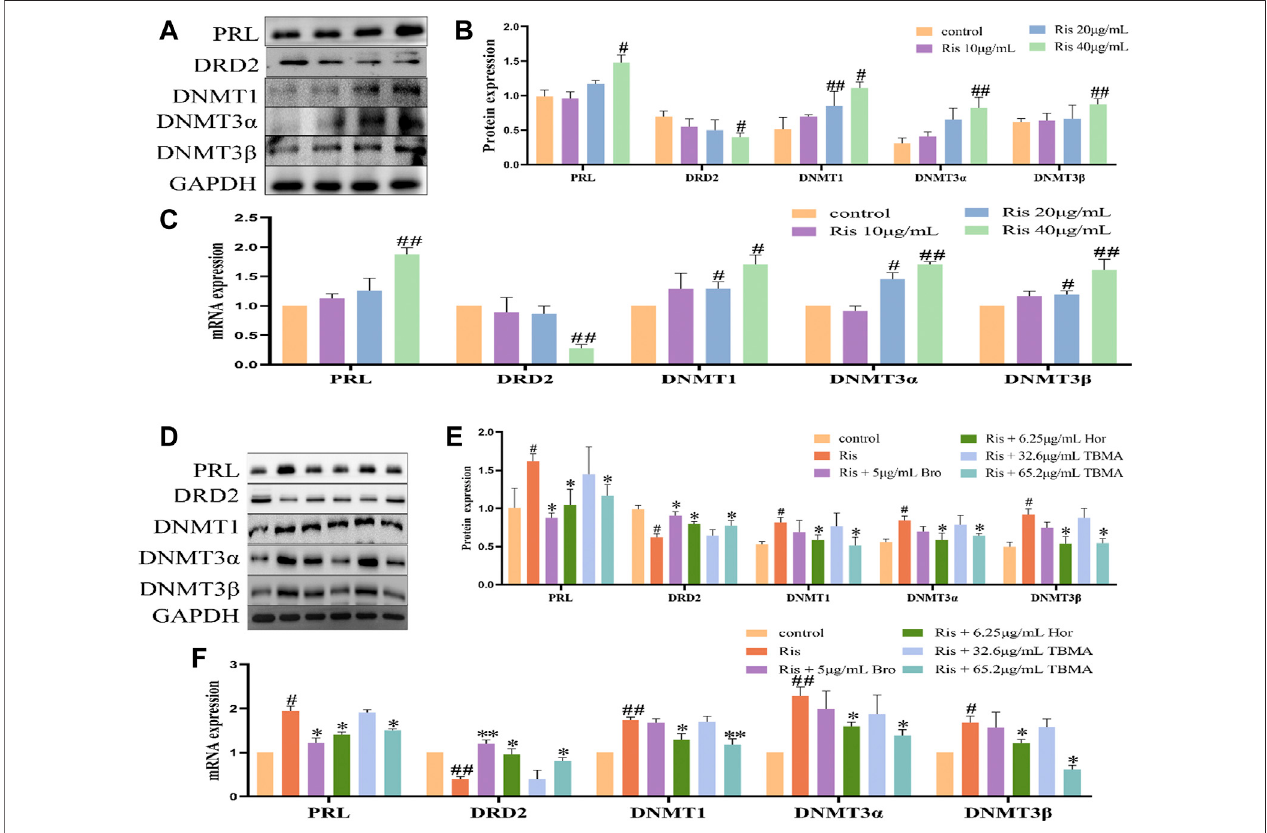
FIGURE6| TBMAand hordenineregulatedDRD2DNAmethylation. (A,B) PRL,DRD2,andDNMT proteinexpression bywesternblottingfollowingtreatmentwith different risperidone concentrations ( n = 3). (C) PRL, DRD2, and DNMT mRNA expression levels by RT-PCR following different risperidone concentrations ( n = 3). (D,E) WB was used to detect PRL, DRD2, and DNMT protein expression by western blotting following TBMA or hordenine treatment of MMQ cells ( n = 3). (F) was used to detect themRNAlevelsofPRL, DRD2, and DNMTmRNA expression byRT-PCR followingTBMAor hordenine treatment ofMMQ cells ( n =3). Dataarepresented as the mean ± SD ( # p < 0.05 and ## p < 0.01 versus the control group; *p < 0.05 and **p < 0.01 versus the Ris group). Hor = hordenine; Ris = risperidone; TBMA = total barley maiya alkaloids.